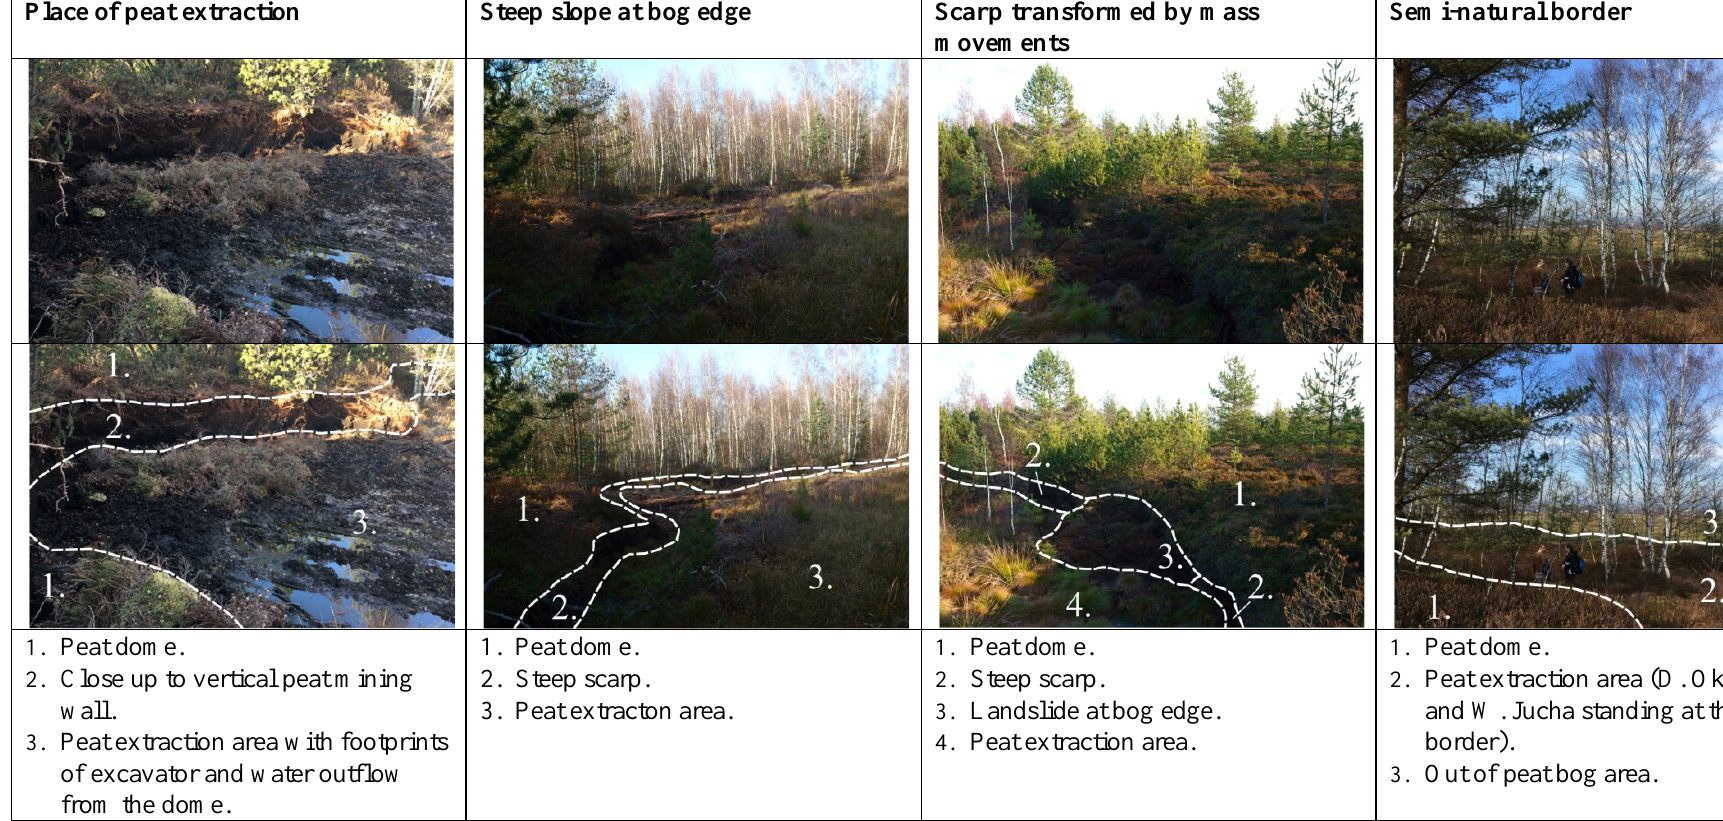
Figure A1. Photographic documentation of types of border between dome and peat extraction area. Place of peat